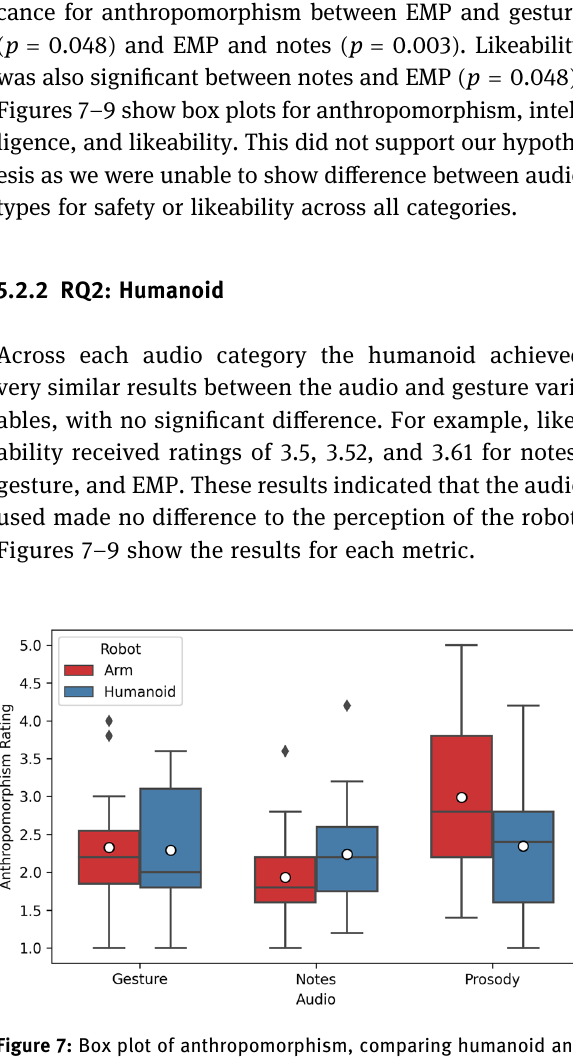
Figure 7: Box plot of anthropomorphism, comparing humanoid and arm across audio types. White dot indicates mean, middle line is median, and black dots are